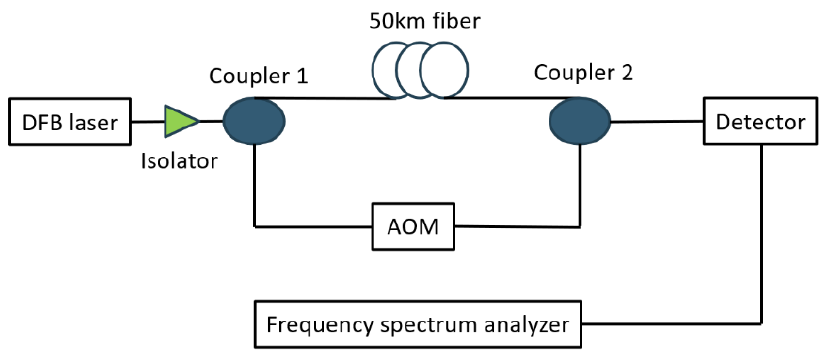
Figure 2. Delayed self-heterodyne linewidth test system.